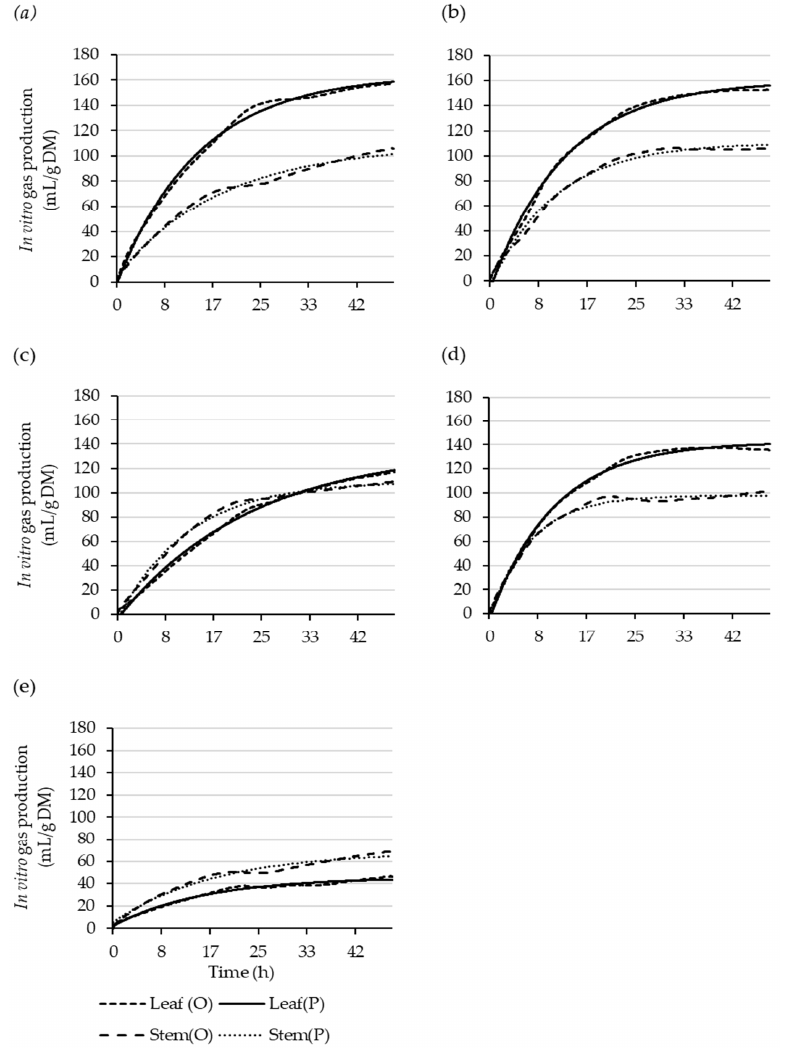
Figure 1. Observed (O) and single-pool-model-predicted (P) leaf and stem cumulative gas-production curves over 48 h for Coprosma robusta ( a ), Griselinia littoralis ( b ), Hoheria populnea ( c ), Pittosporum crassifolium ( d ), and Salix schwerinii ( e ). The dual ‐ pool ‐ model in vitro fermentation kinetic parameter estimates for the leaves and stems are shown in Tables 7 and 8, and the resulting predicted gas ‐ production curves are presented in Figure 2. The predicted leaf gas production from the fast pool ( 𝑉 (cid:2869) , mL/g